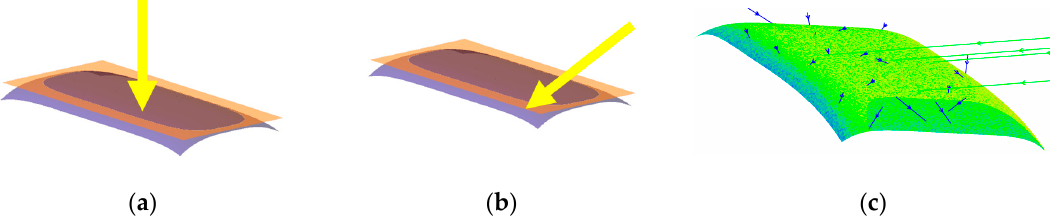
Figure 6. Illustration of the multiple definitions of the module area: ( a ) principle ray direction in testing, although the illumination by the typical solar simulators is not collimated, and the field of view is typically ±10° to ±45°; ( b ) principle ray direction in the outdoor operation. The outdoor illumination is the mixture of the collimated light (direct sunlight) and diffused sunlight (illumination from the sky and reflection by surroundings). The ratio of the collimated and diffused light varies by climate; ( c ) example of the distribution level in the outdoor operation calculated by the ray-tracing simulation. The light-green arrow lines correspond to the direct sunlight. The blue arrow lines correspond to the scattered sunlight. The color gladiation on the curved surface indicates the non-uniformity of the irradiance on the curved surface. The darker color indicates lower irradiance.